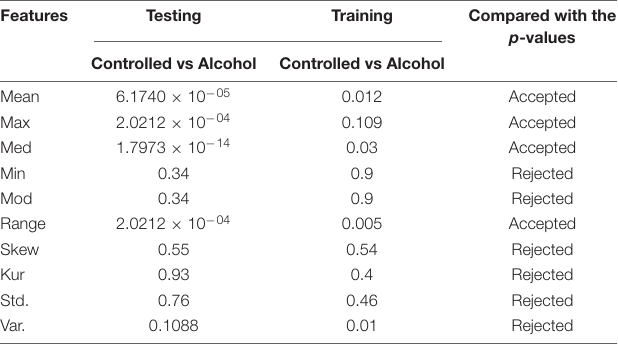
TABLE 5 | Feature set outcome of Experiment No. 5.